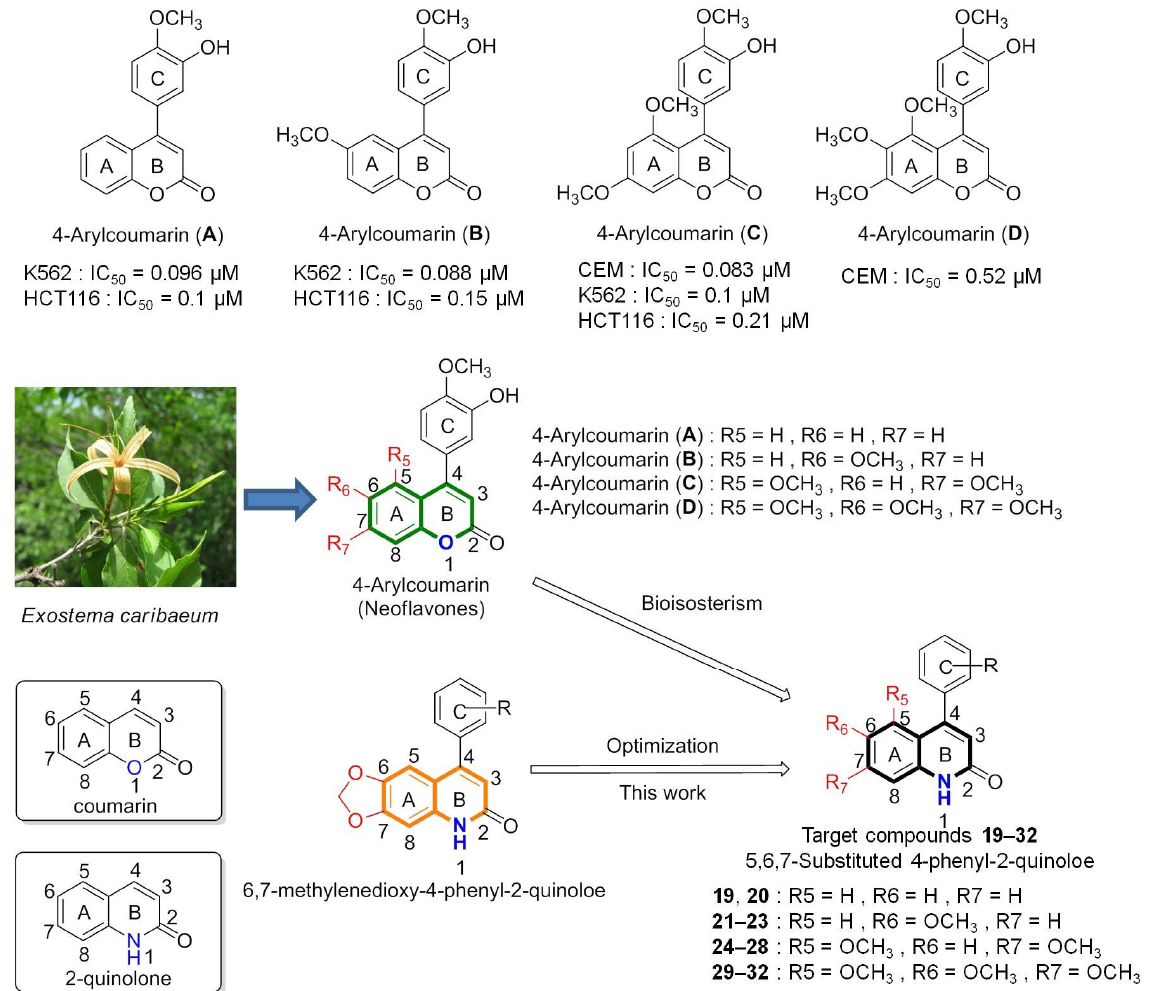
Figure 2. Rational design of 4-phenylquinolin-2(1 H )-one (4-PQ) derivatives as anticancer drugs using the bio-isosteric concept.